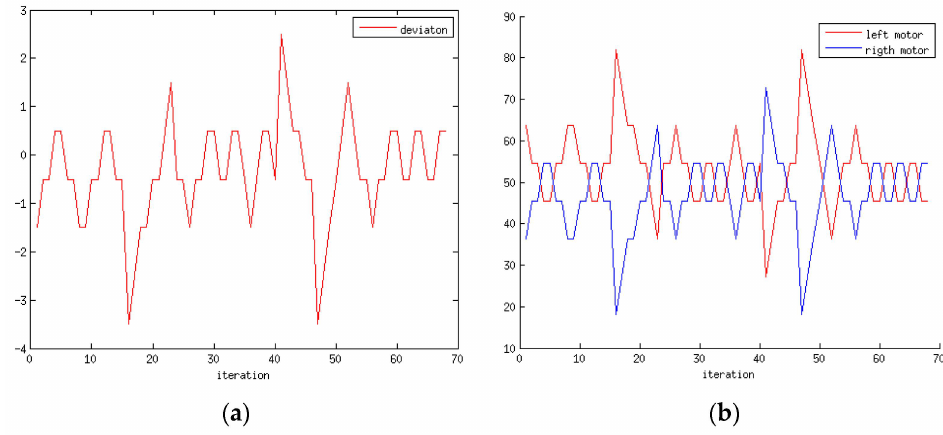
Figure 15. ( a ) Deviation of the line detected by the robot’s sensors; ( b ) Speed applied to each motor by the closed-loop controller to correct the